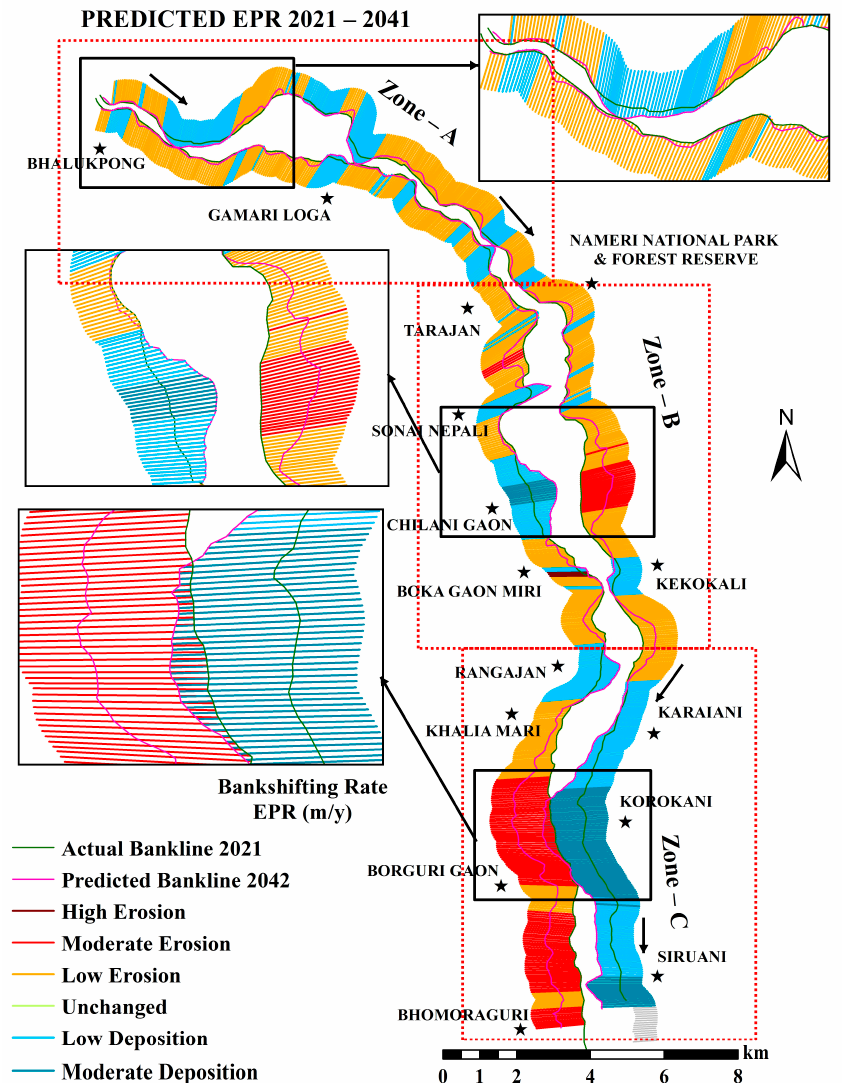
Figure 9. Spatial distribution of erosion and deposition (EPR-based) during the predicted period of 2021 to 2041.